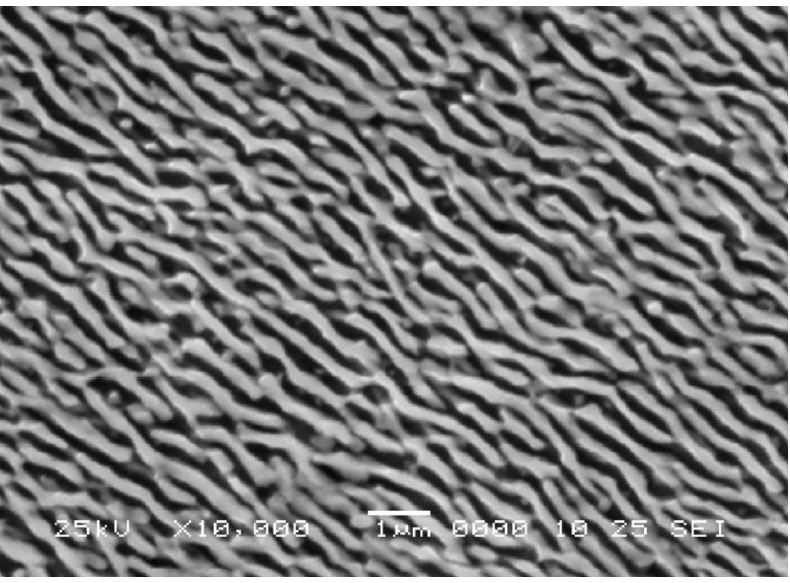
Figure 6. Scanning electron micrograph of longitudinal section of Ni-based single crystal alloy (KS-3, see Section 3) creep tested at 1000 °C and 170 MPa for 100 h [11]. Copyright 2008 Elsevier.